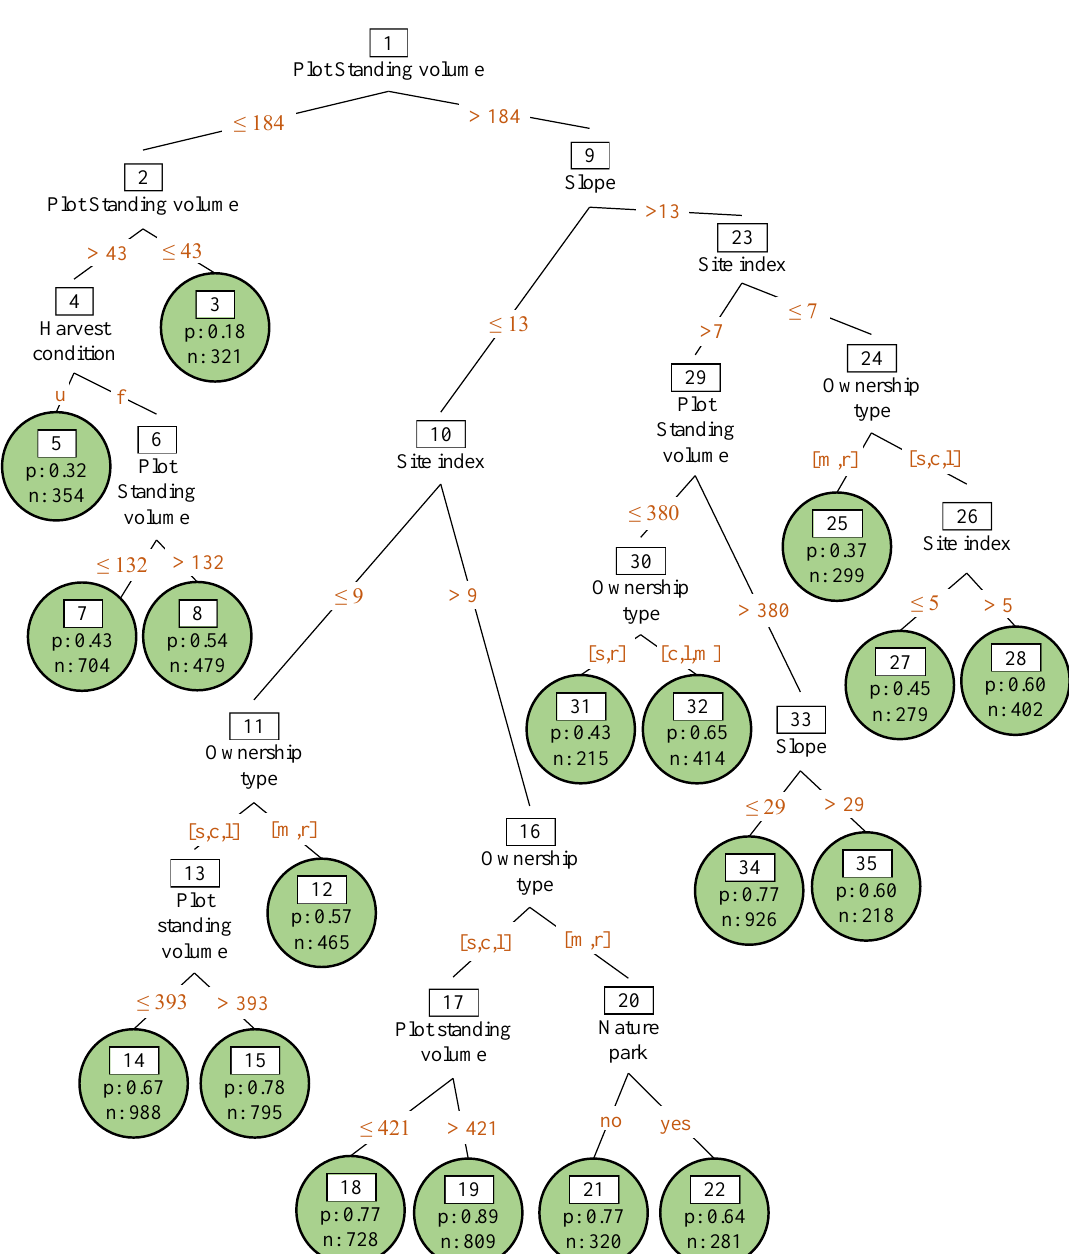
Figure A1. Classification tree based on the conditional inference tree (CTree) algorithm used to classify plots into strata to generate the plot harvest stratum attribute (p: harvest probability; n: number of training set plots; Ownership type as s: state; c: community; l: large private; m: medium private; r: small private; Harvest condition as f: favorable; u: unfavorable; Plot standing volume in m 3 over bark (ob) ha − 1 ; Site index as average yearly total increment in m 3 ob ha − 1 over 100 years; Slope in %).